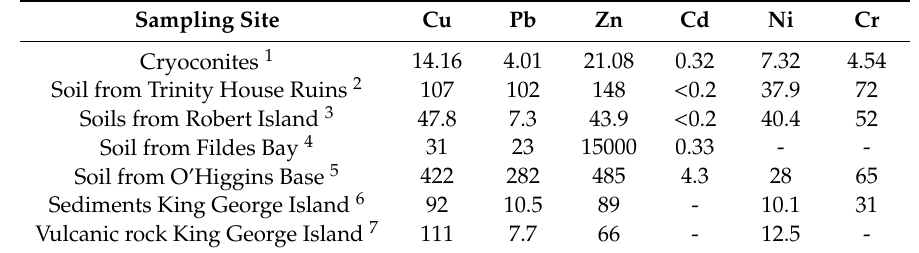
studies (mg · kg − 1 ).